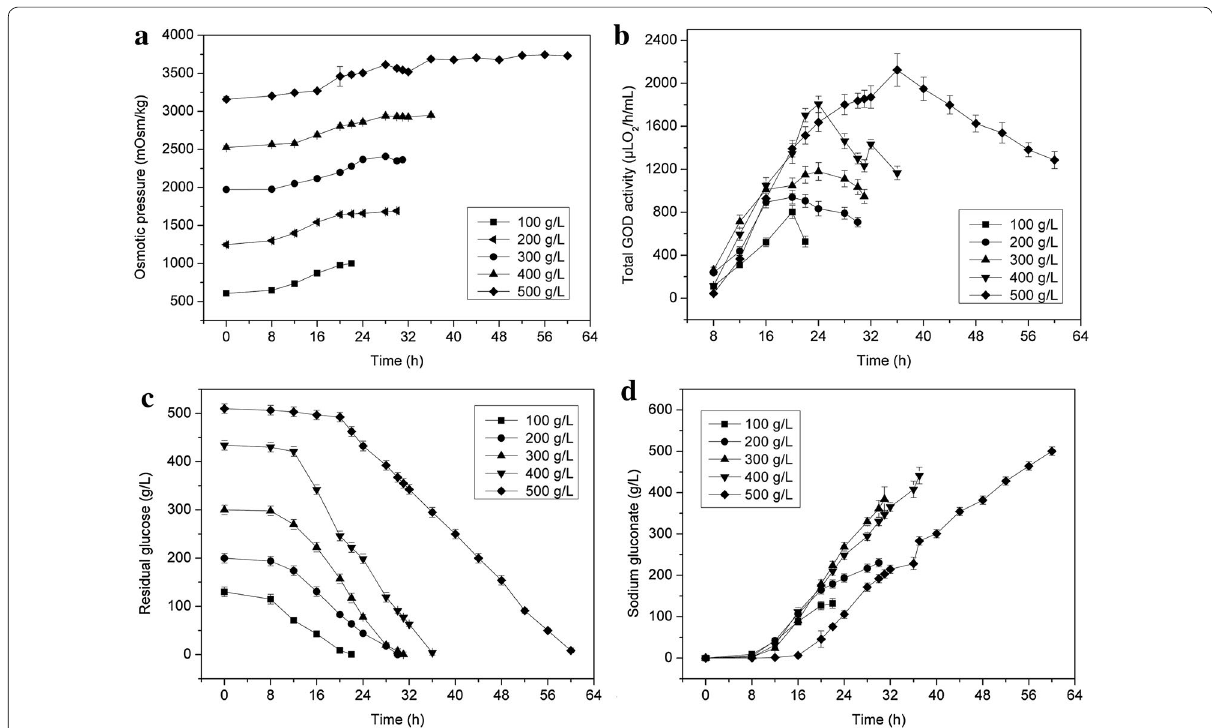
Table 1 Effects of different initial glucose concentrations on DCW in seed culture by A. niger Time